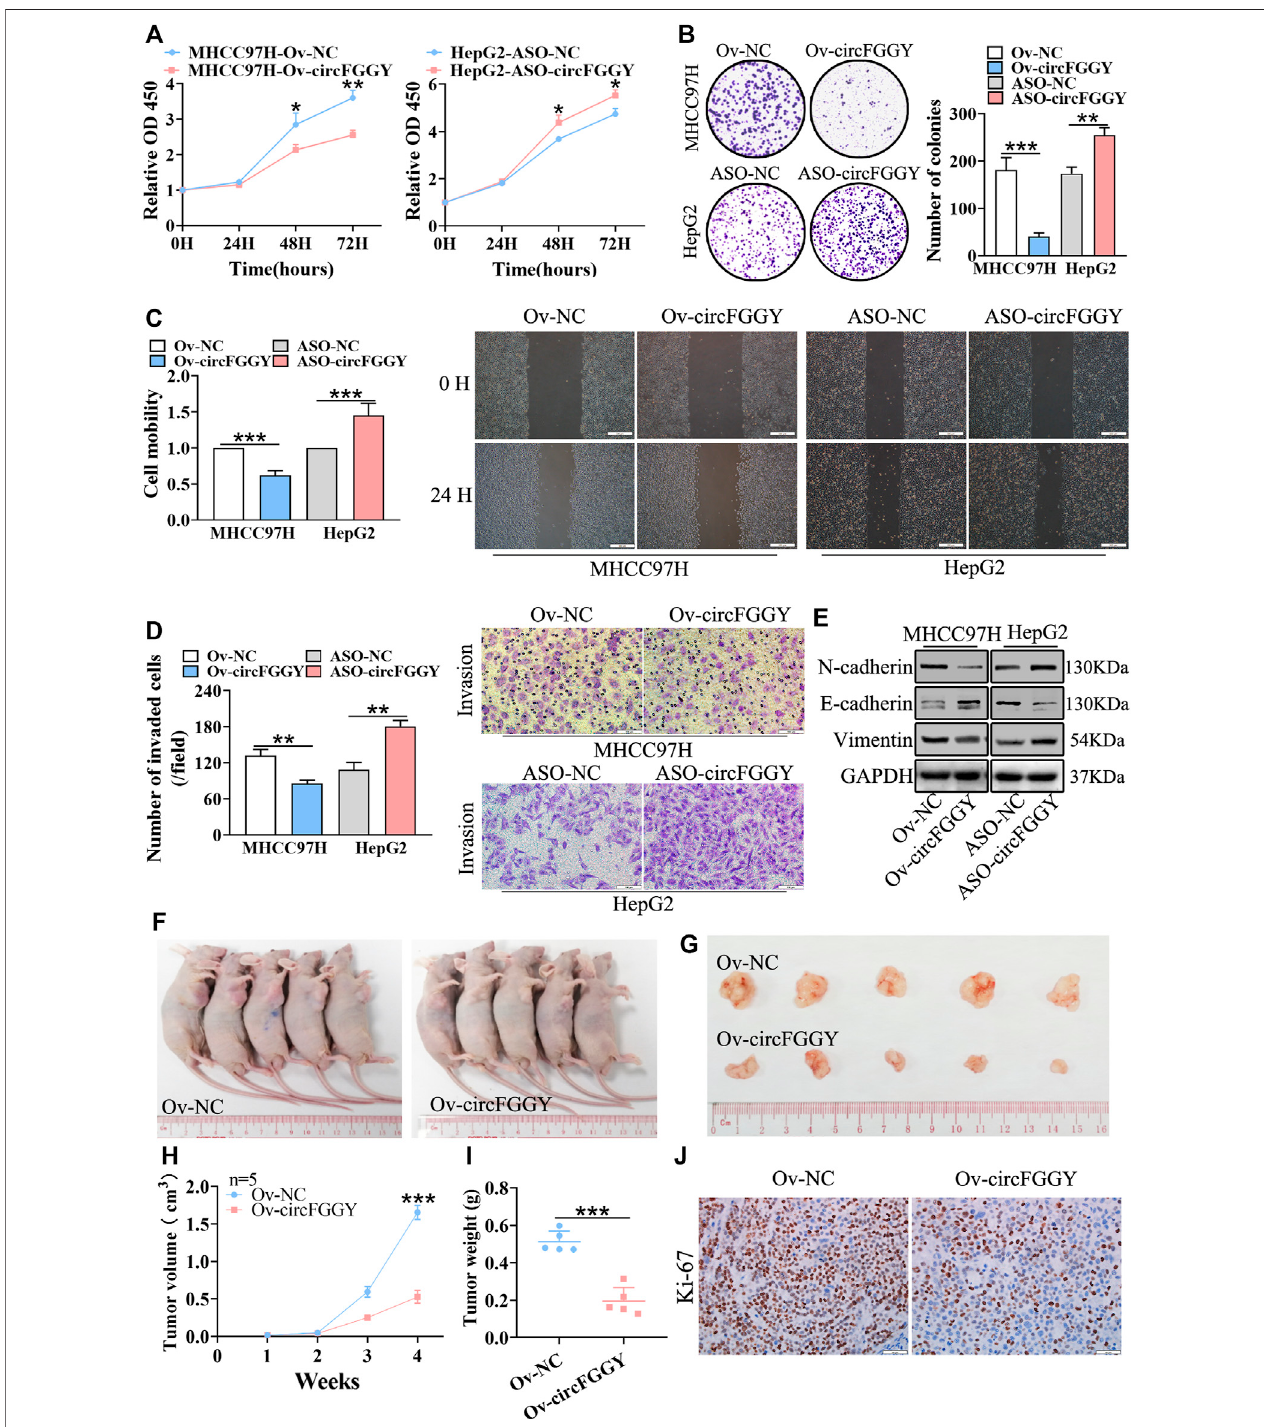
FIGURE3| CircFGGYinhibitsHCCgrowth,migration,invasionandEMTboth invitro andvivo.A-D.CCk8assays (A) ,colonyformationassays (B) ,scratchwound healing assay (C) and transwell invasion assay (D) assessed the cell proliferation, colony formation, migration and invasion potential in MHCC97H cells transfected with the circFGGY overexpression vector and HepG2 cells transfected with the circFGGY ASO ( n = 3). Scale bar, 500 µm (C) , 100 µm (D) . (E) Western blot detected the expressionoftheEMTbiomarkersinMHCC97HcellstransfectedwithcircFGGYoverexpressionvectorandHepG2cellstransfectedwithASO-circFGGY. (F) Nude mice inoculated subcutaneously with the circFGGY-overexpressing MHCC97H cells or NC cells. (G) Representative images of the MHCC97H xenograft tumors after 4 weeksoftumorgrowthinthecircFGGYoverexpressionandNCgroups. (H,I) Thevolumeandweightofsubcutaneousxenografttumors( n =5). (J) IHCanalysisonKi- 67 expression in xenograft tumor tissues from the circFGGY overexpression and NC groups. Scale bar, 50 µm. Data were shown as mean ± SD. * p < 0.05, ** p < 0.01, *** p < 0.001 in two-way ANOVA (A,H) or independent Student ’ s t test (B,C,D,I) .